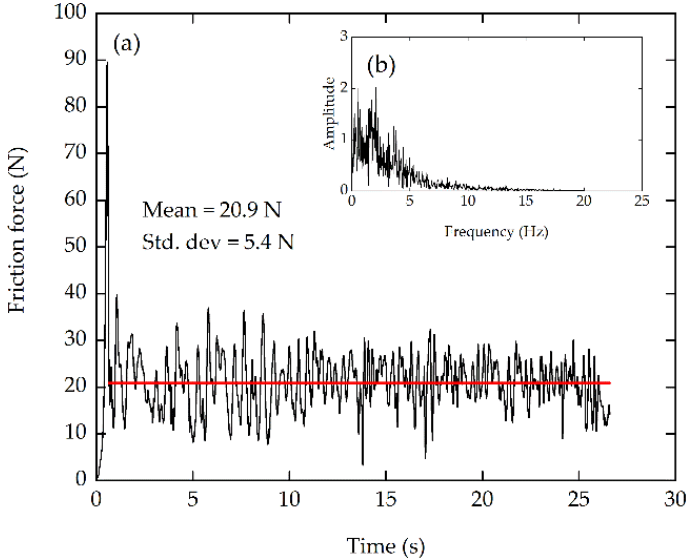
Figure 4. ( a ) Steady-sliding friction for SS-Top at a velocity of 0.19 m·s −1 and a normal stress of 3.10 kPa. The mean friction force of the stationary portion used in calculation was 20.9 N (red line) and the standard deviation was 5.4 N; ( b ) Frequency of load oscillations in steady sliding.